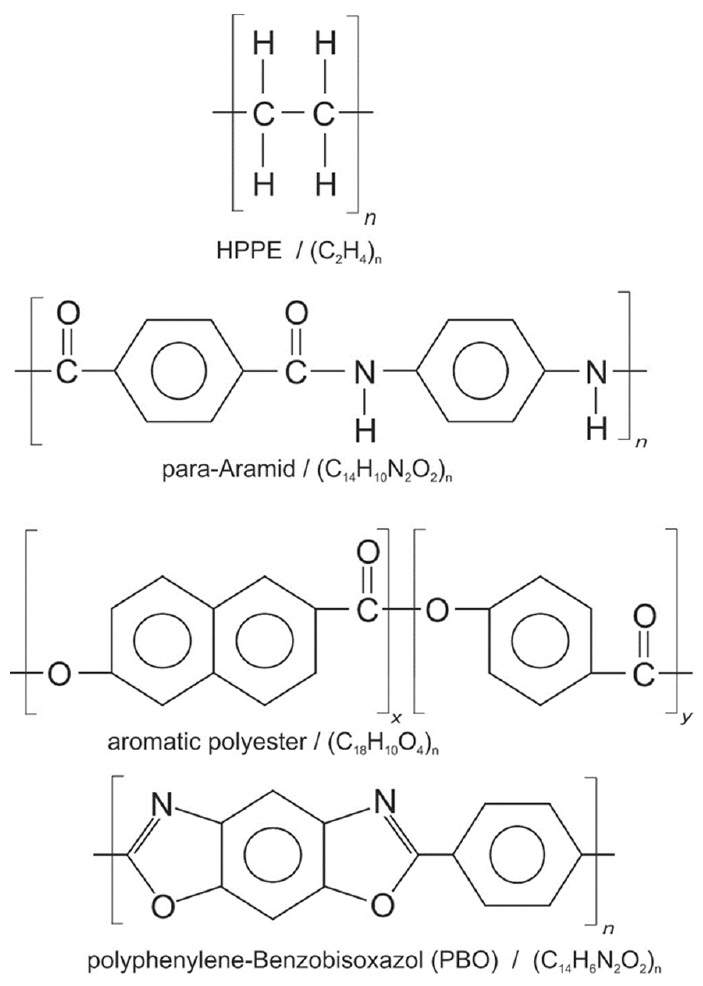
Figure 5. Chemical structures and sum formulas of high-performance fibers with high mechanical Figure 5. strength.